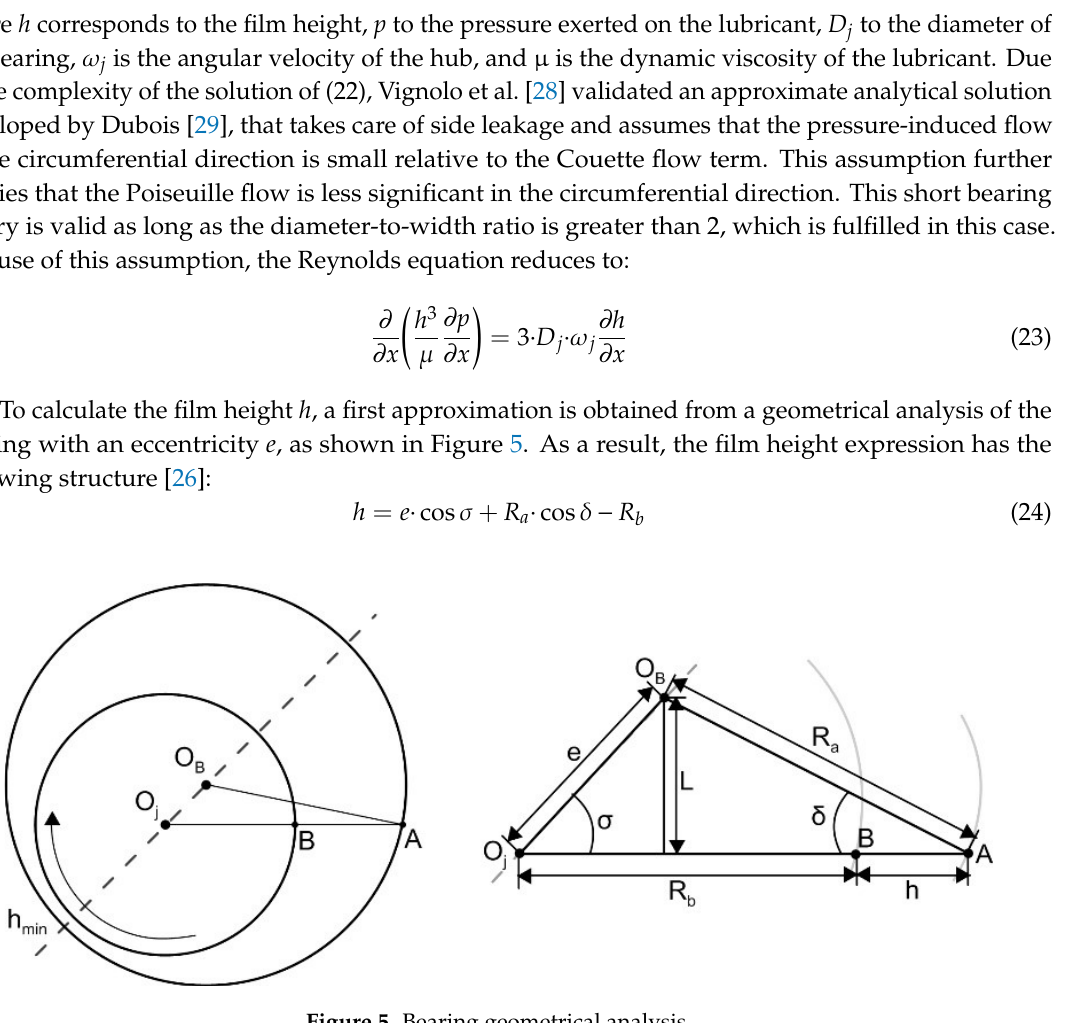
Figure 5. Bearing geometrical analysis.